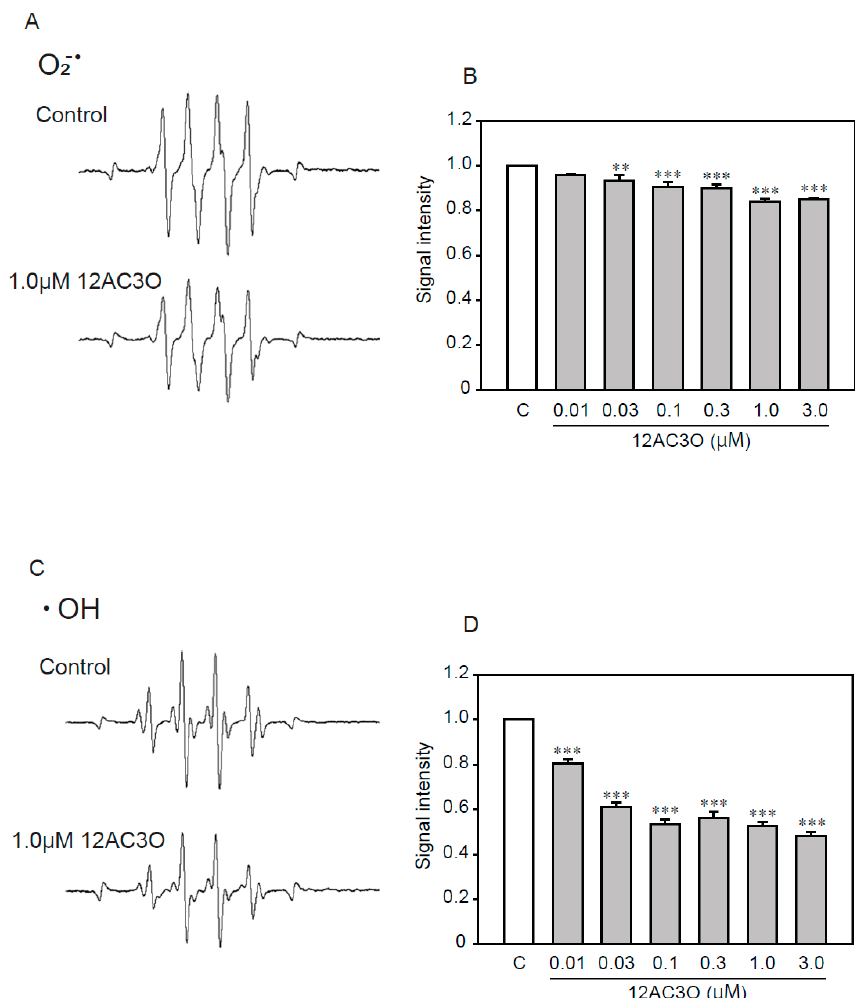
Figure 6. The direct trapping e ff ect of 12AC3O against superoxide anion and hydroxyl radical. ( A ) Typical spectra of DMPO ‐ OOH spin adduct. ( B ) Semi ‐ quantitative measurement of DMPO ‐ OOH spin adduct. ( C ) Typical spectra of DMPO ‐ OH spin adduct. ( D ) Semi ‐ quantitative measurement of DMPO ‐ OH spin adduct. Results are presented as the mean ± S.E.M of four determinations based on the control. C: Control. ** p < 0.01, *** p < 0.001.